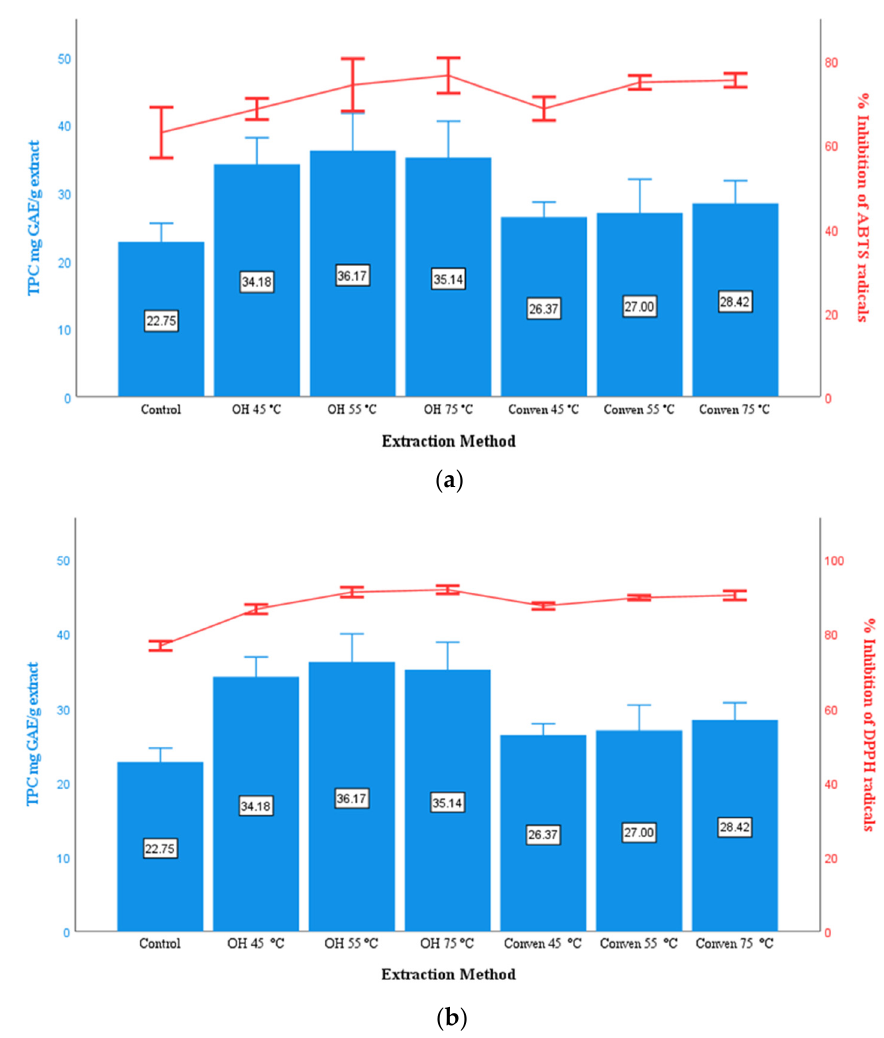
Figure 6. ( a ) Relationship between % ABTS radical scavenging activity and total phenolic content. ( b ) Relationship between % DPPH radical scavenging activity and total phenolic content. The values were obtained from various extraction methods (OH, Conven, and Control). Error bars represent the standard deviation ( p < 0.05).